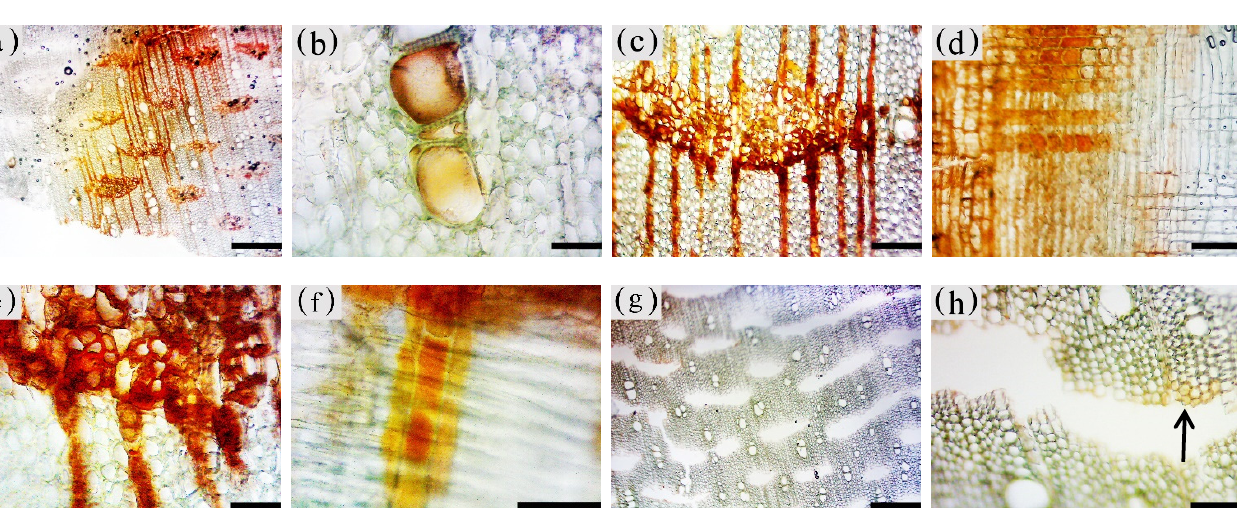
( g ) Transverse surface of decay zone. ( h ) Transverse surface of decay zone, the edges of the undecayed